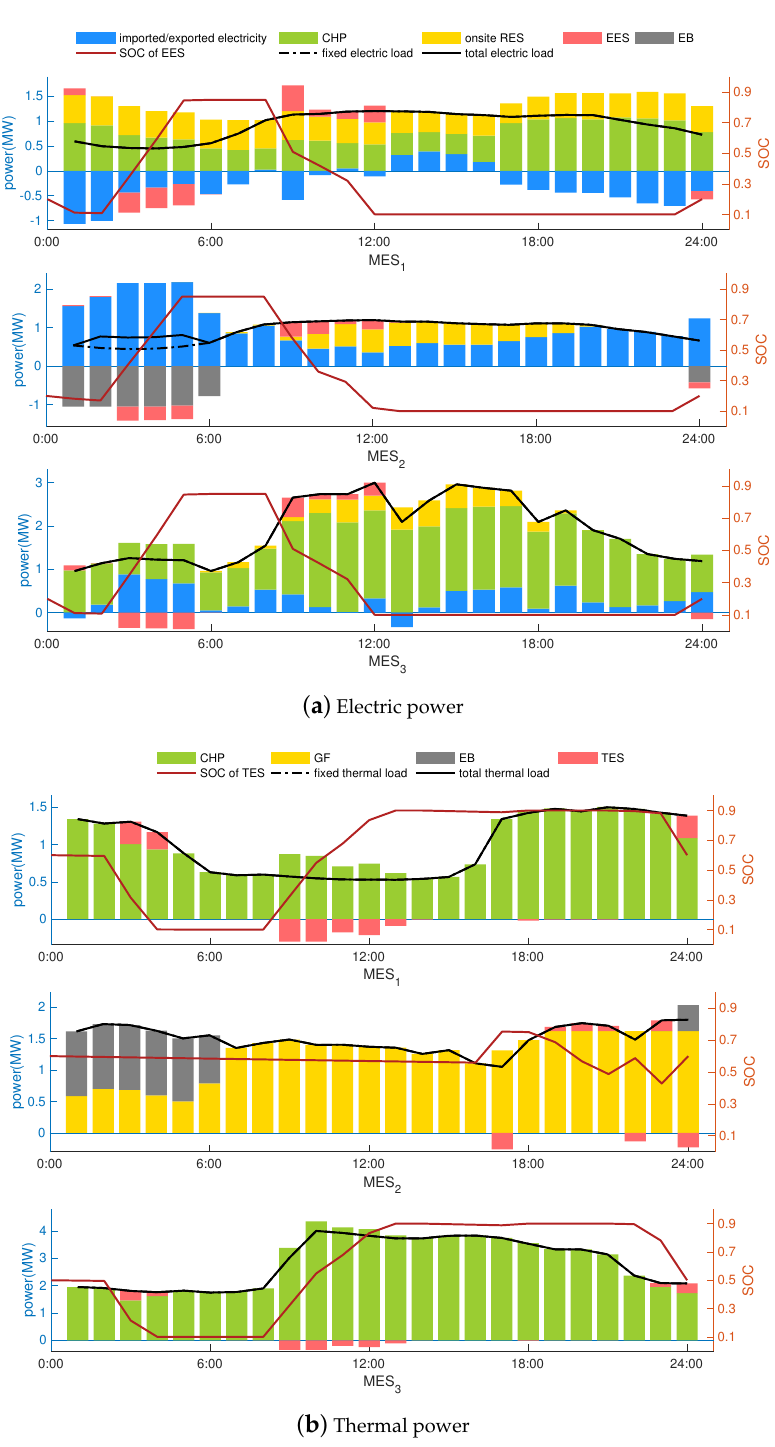
Figure 7. Result of each MES’s ( a ) electric and ( b ) thermal